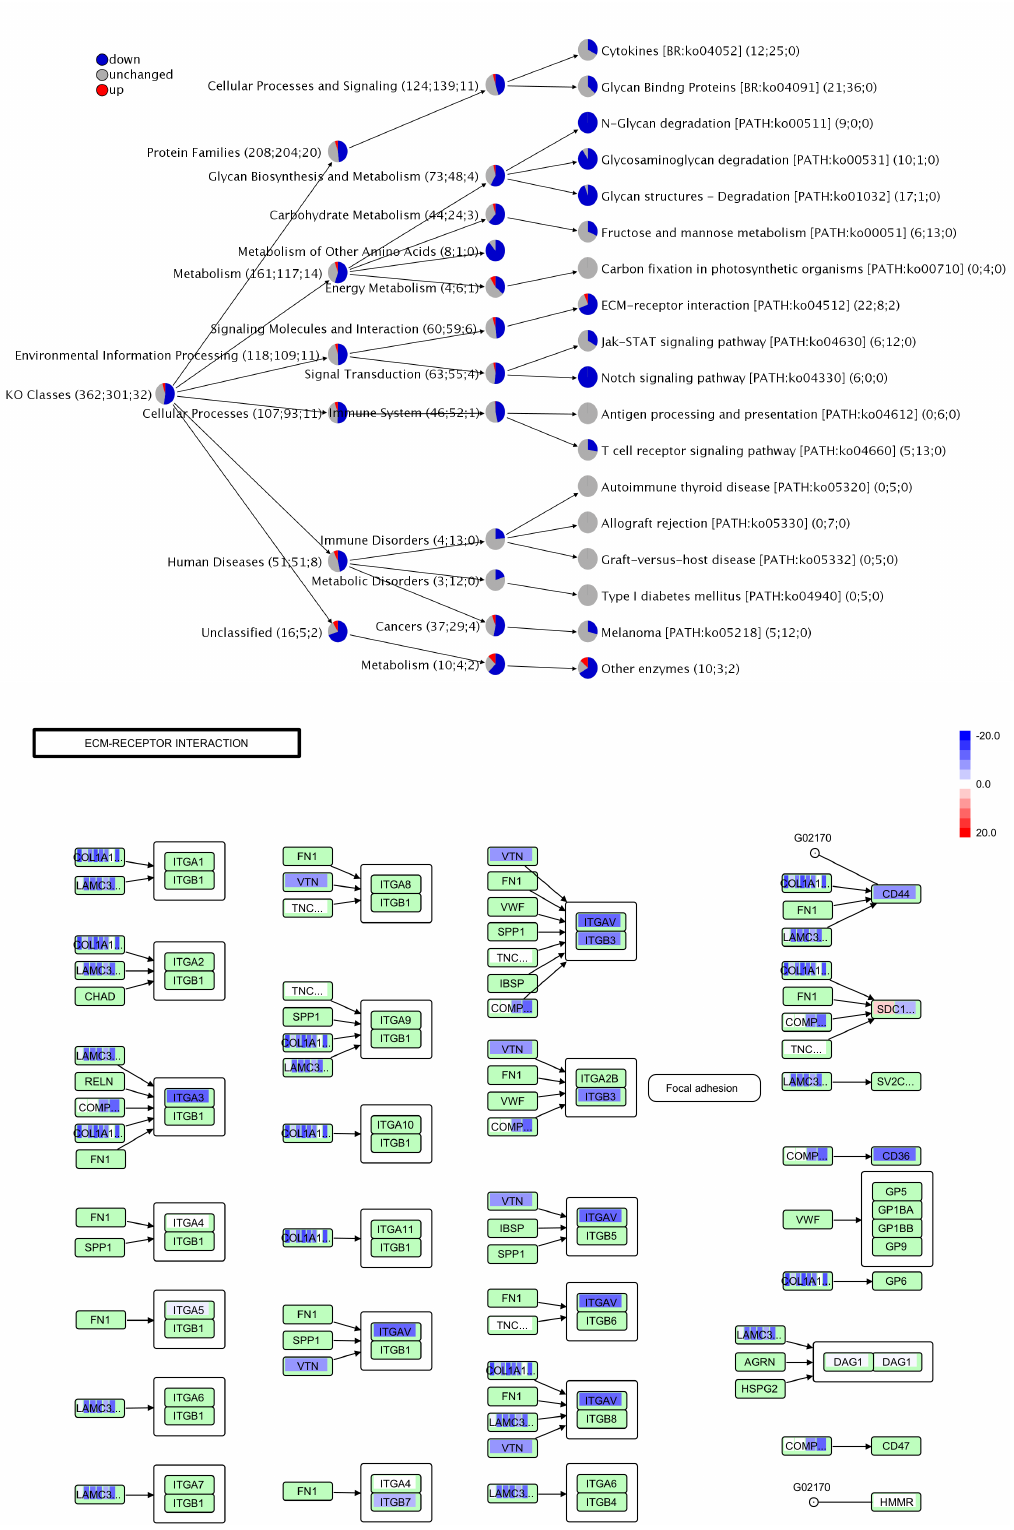
Figure 2: Top: KEGG BRITE pathway hierarchy (by means of Fisher’s exact test as significant recognized pathways). Note that only classification nodes CN are shown. Bottom: ECM-Receptor Interaction pathway with detailed representation of up- (red) and down-regulated (blue)